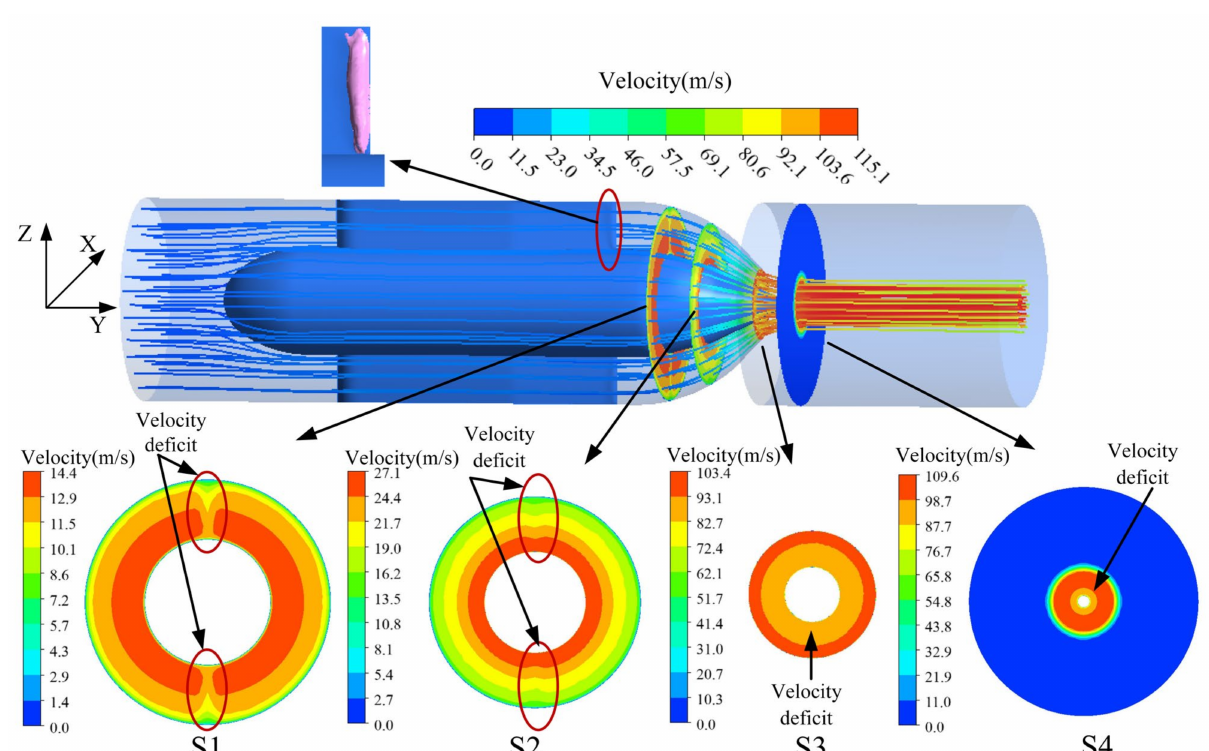
Figure 4. Flow line diagram and 4 cross-sectional velocity